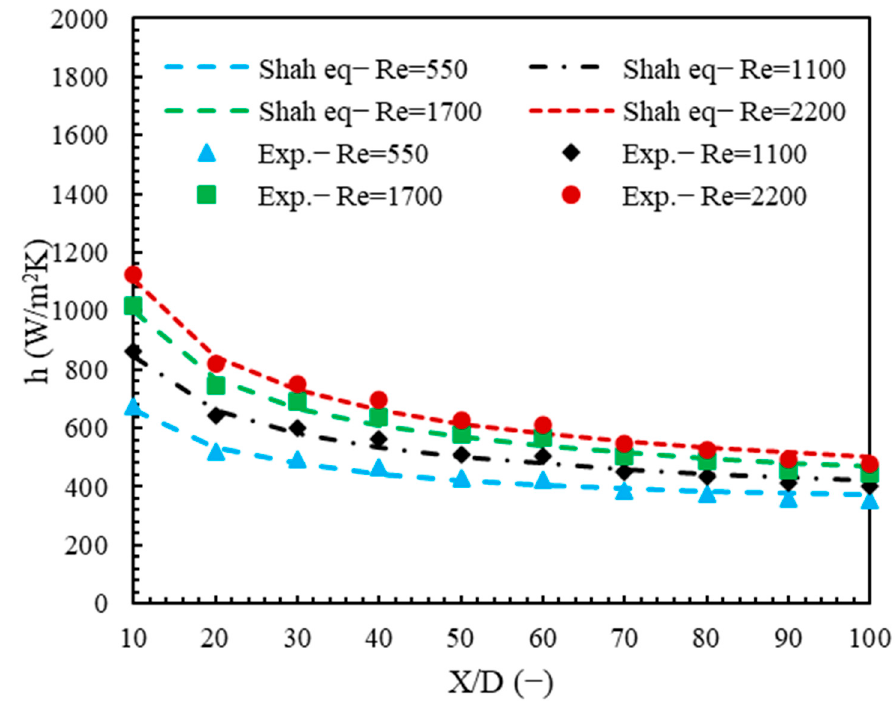
Figure 2. The validation of the experimental data with the analytical results for h.